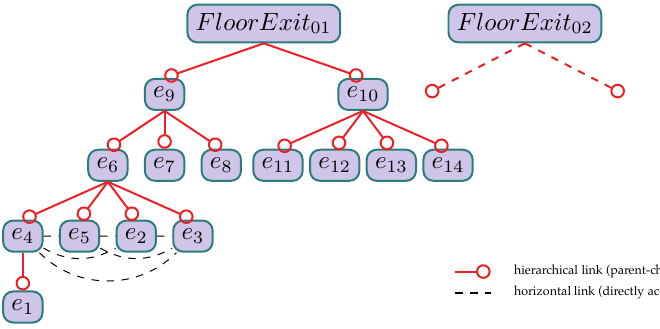
Figure 12: Part of an exit hierarchy derived from a fi ne-grained graph (Floor-01, Building-1 of Figure